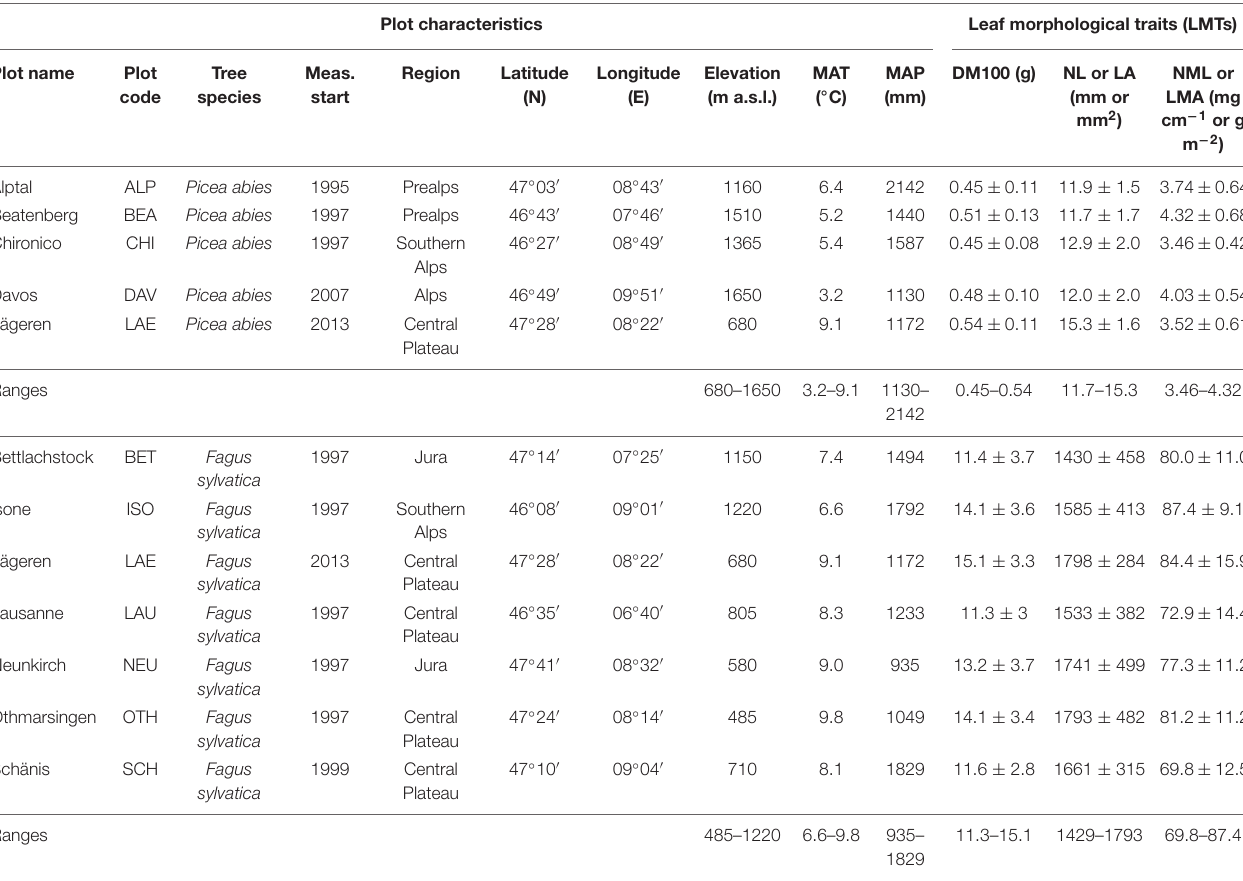
TABLE 1 | Plot characteristics, ranges and average long-term leaf morphological traits (LMTs) for 11 study plots (6 beech, 4 spruce, and 1 mixed stand). Plot characteristics Leaf morphological traits